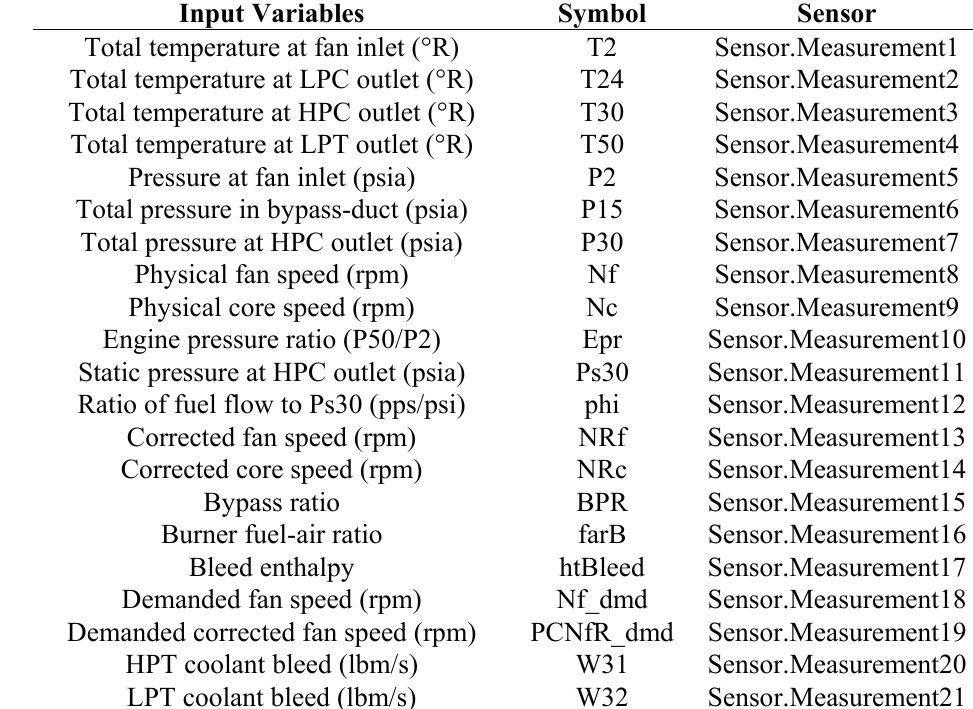
Table 1. MAPSS input variables of the simulated engine to simulate the remaining useful life